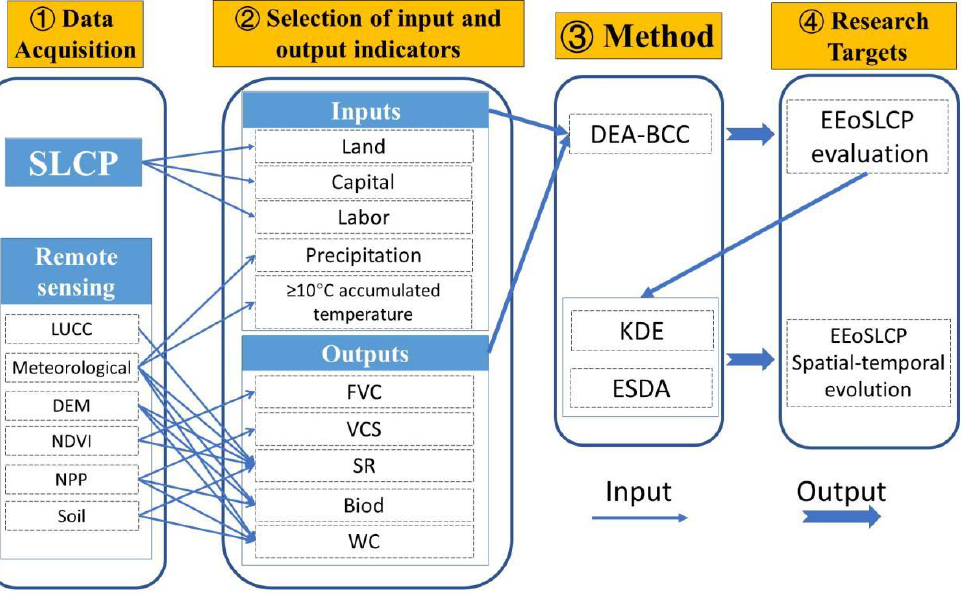
Figure 2. EEoSLCP evaluation and its spatial and temporal variation research framework.